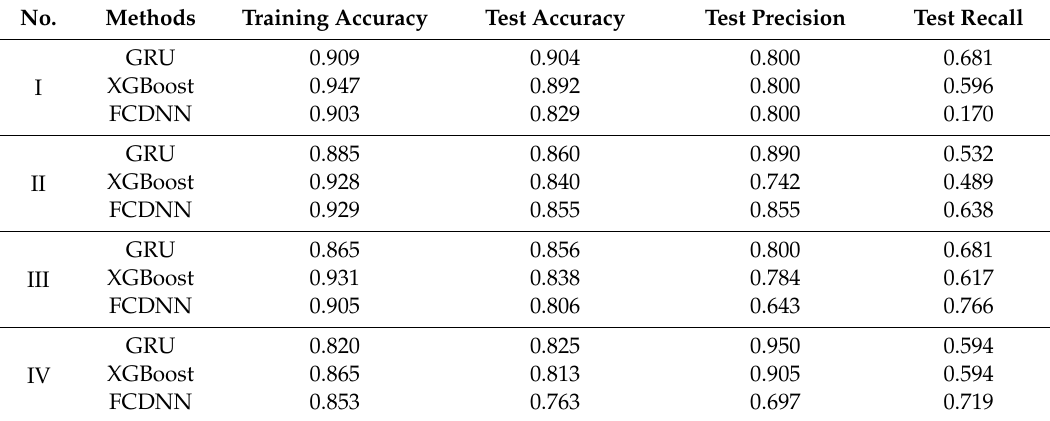
Table 3. Comparisons among the three methods in di ff erent